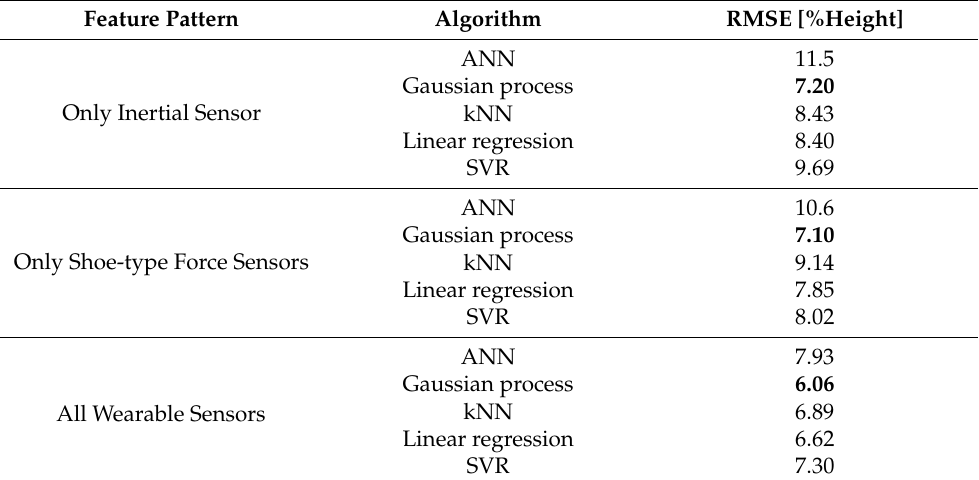
Table 7. Root mean square error values of anteroposterior foot distances.